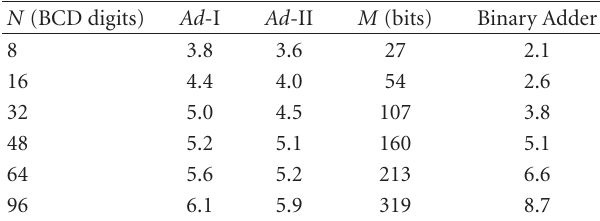
Table 3: Delays in ns for decimal and binary adders in Virtex-5 -2.